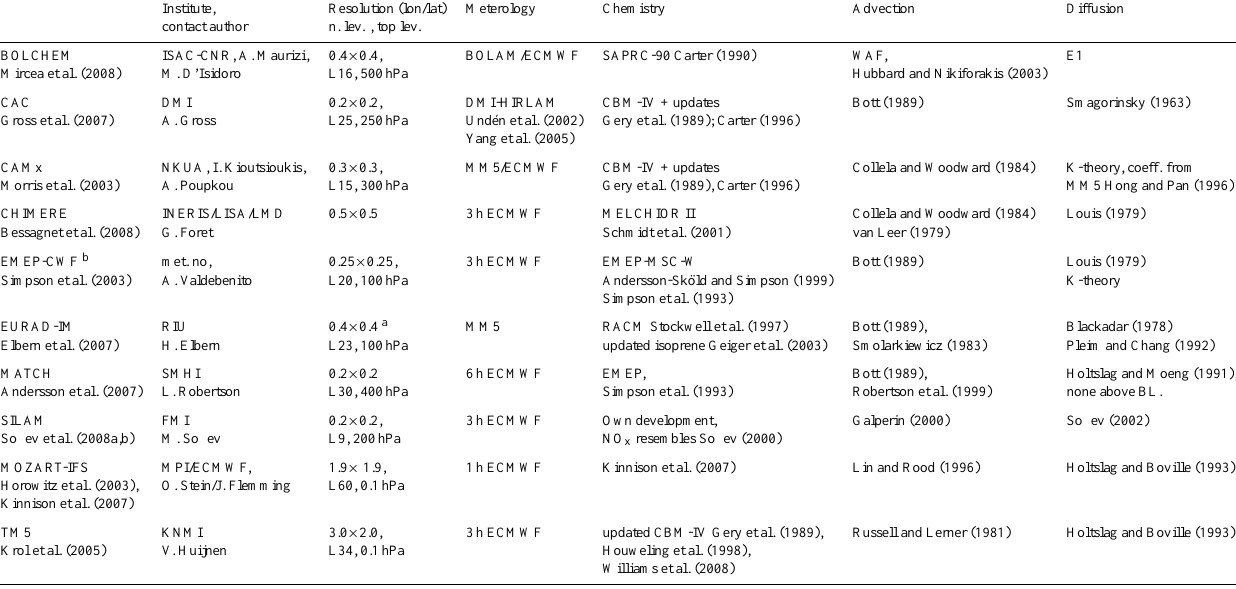
Table 1. Specifications of the global and regional